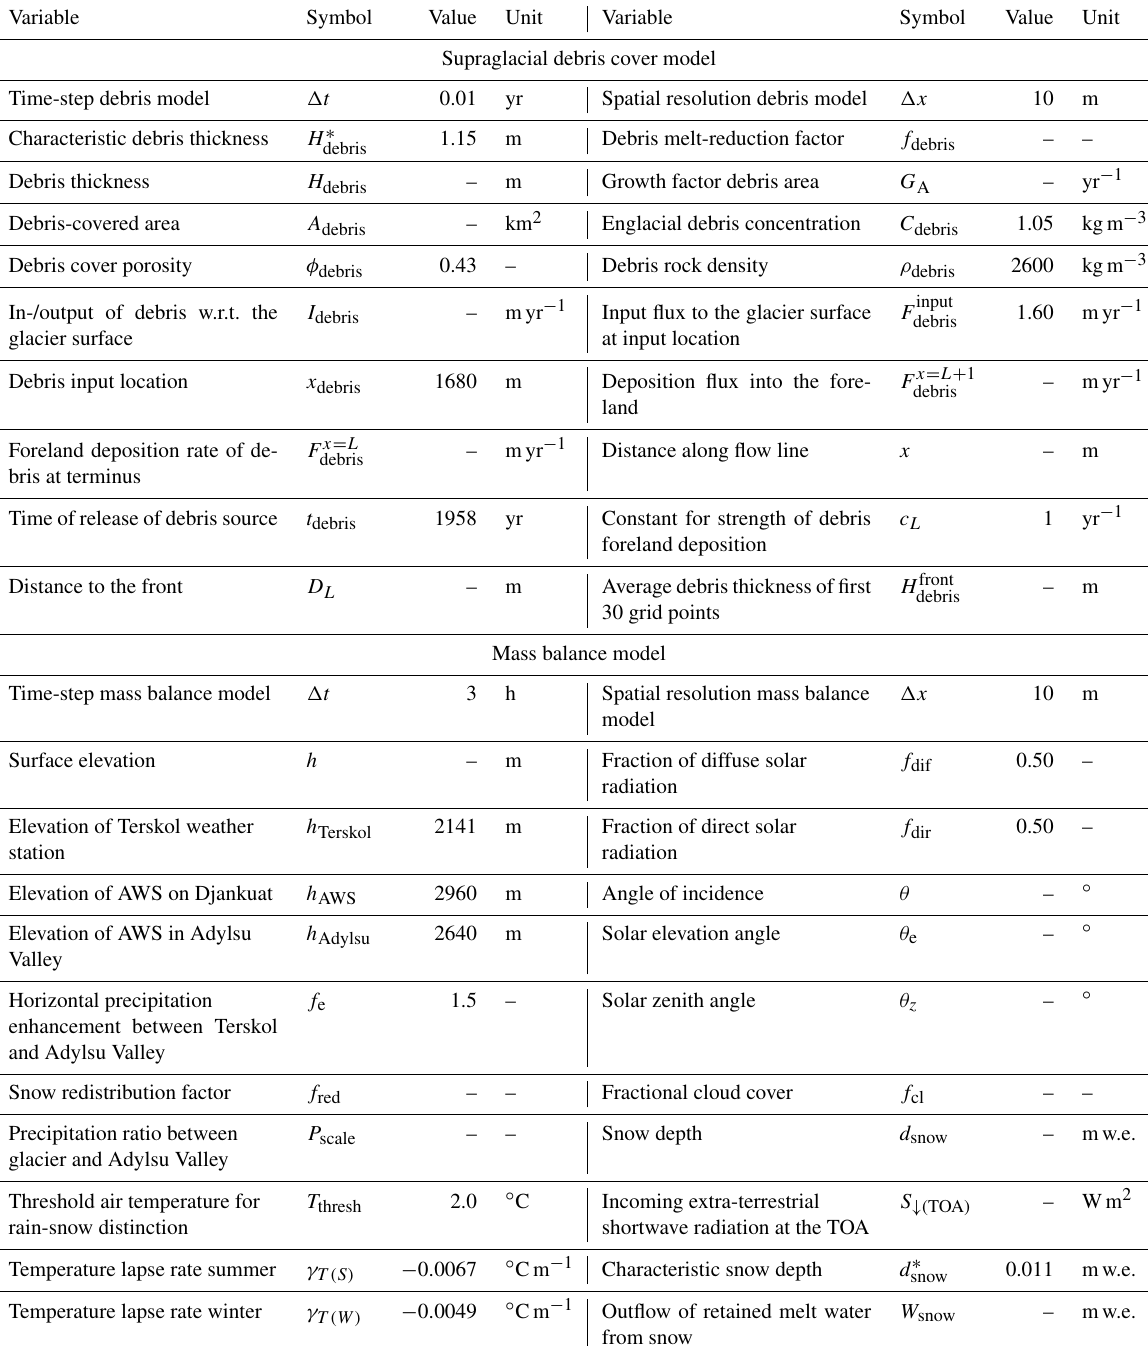
Table 1. Variables, constants and their units used in the model. The dash (–) denotes that the value is not a constant.